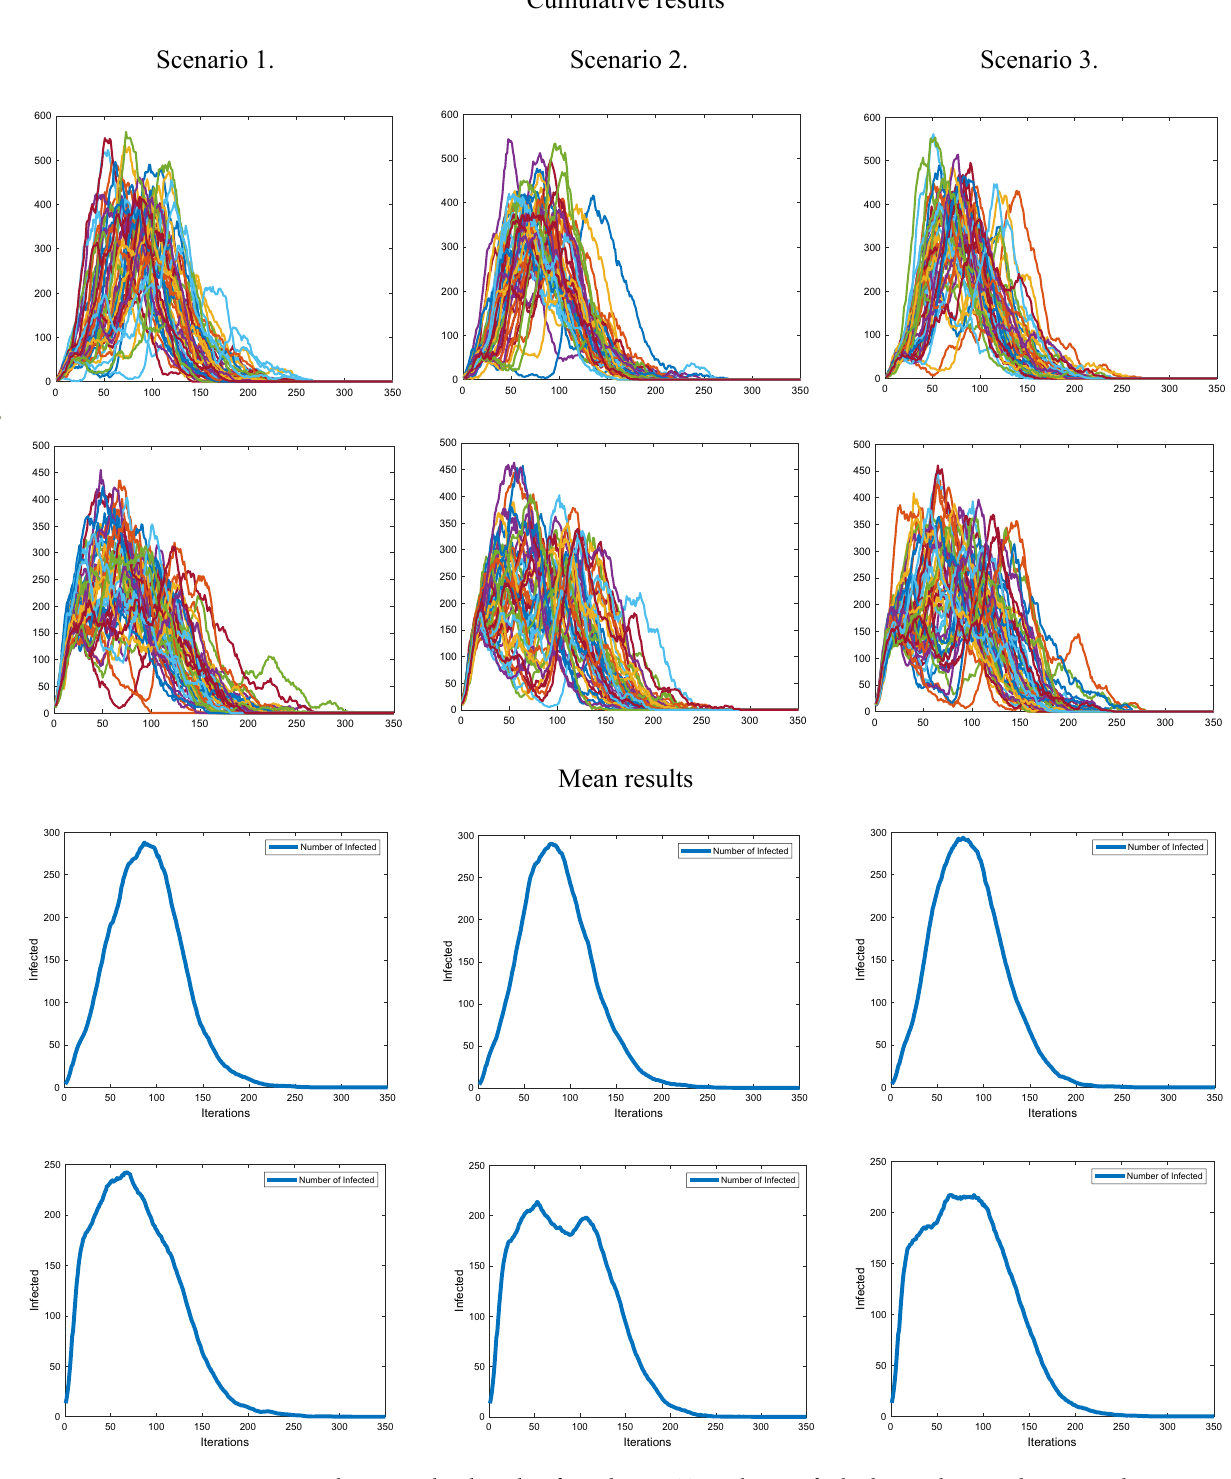
Figure 3. Shows Graphical results of simulations. Top to bottom for both cumulative and mean results are according to the sourcing (starting) positions of the pathogen, smallest and largest city,